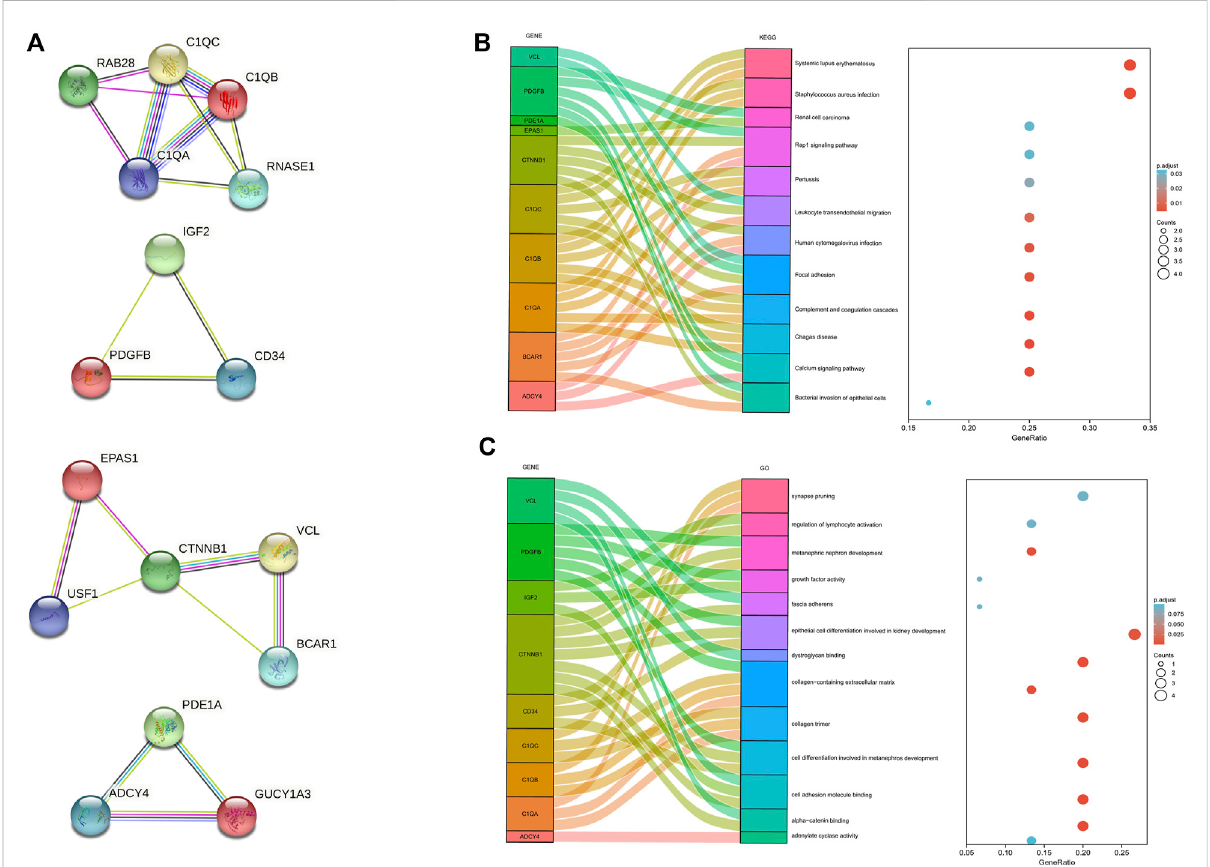
FIGURE 5 Signi fi cant gene module and function analysis of the model genes. (A) , Four signi fi cant gene clustering modules. (B,C) , GO and KEGG enrichmentanalysisofthemodelgenes.Thesizeofthecirclerepresentsthenumberofgenesinvolved,andtheabscissarepresentsthefrequencyof the genes involved in the term total